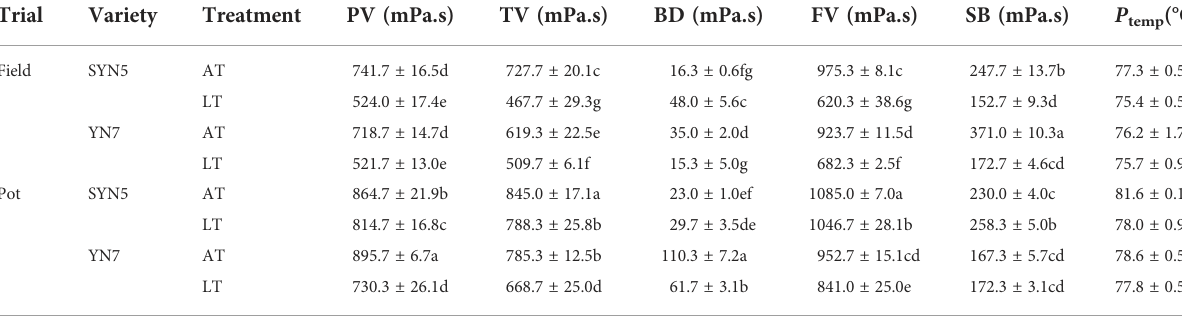
TABLE 1 Effects of post-silking low temperature on fl our pasting properties of waxy maize.